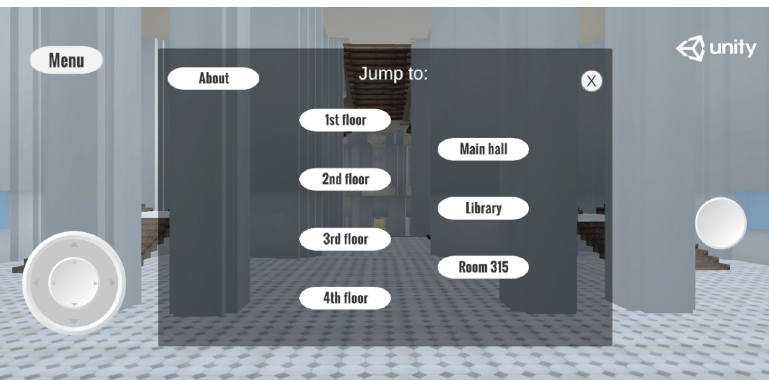
Fig. 11. List of defined places in the building, to which you can quickly move, displayed after clicking the “Menu”